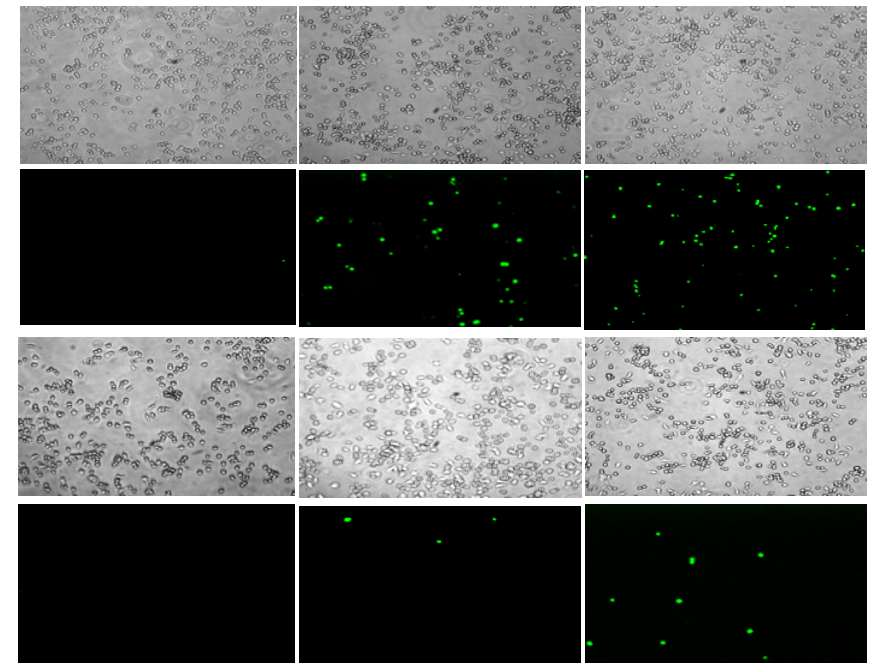
after 37 °C incubation for 30